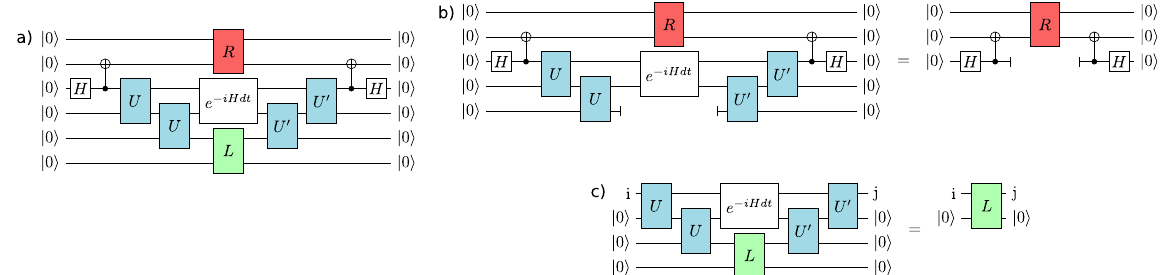
Fig. 3 Quantum implementation of the time-dependent variational principle. For simplicity, we depict the above circuits for D = 2. Higher bond order cases are given in the supplementary materials. a The unitary U 0 that optimises the overlap of this circuit with 000 ¼ j i describes the time evolution of the state described by U ( t ) by a time interval dt under the Hamiltonian H , i.e., U 0 ¼ U ð t þ dt Þ . b , c The mixed environment unitaries R and L are given by the fi xed point solutions of these circuit equations. As in Fig. 2, these are to be interpreted as equality of the density matrices implied by free qubit